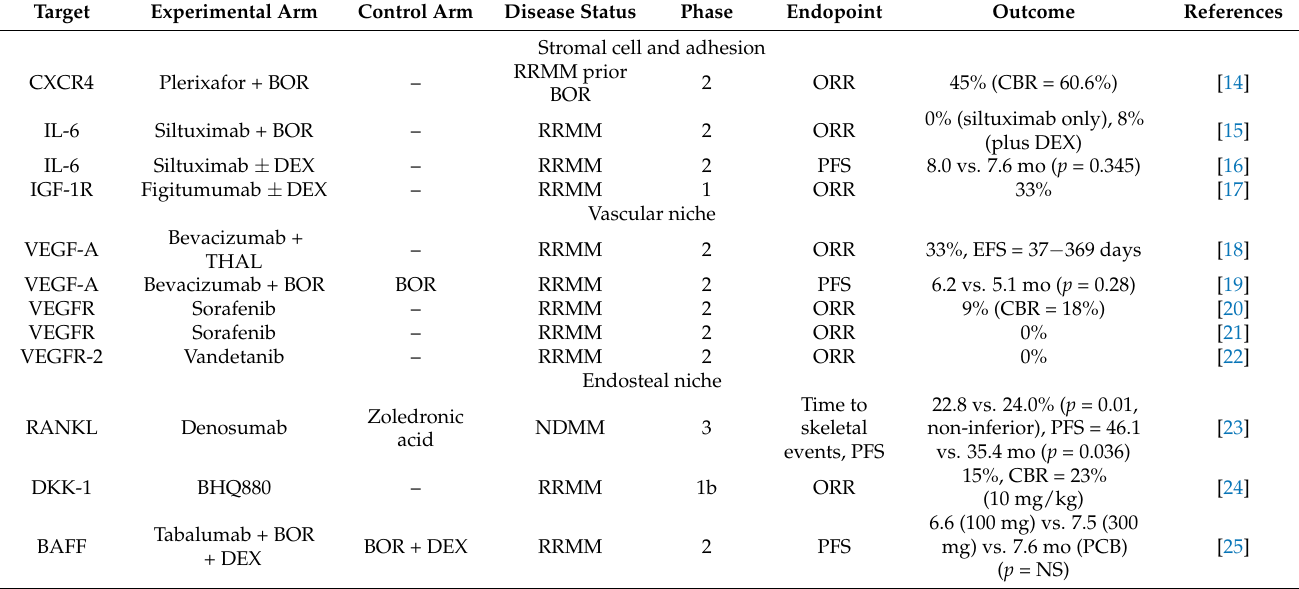
Table 1. Clinical trials of new agents for target concerning bone marrow microenvironments in multiple myeloma (MM). BOR, bortezomib; THAL, thalidomide; DEX, dexamethasone; PCB, placebo; CXCR4, C-X-C chemokine receptor type 4; IL-6, interleukin-6; IGF-1R, insulin-like growth factor-1 receptor; VEGF, vascular endothelial growth factor; VEGFR, vascular endothelial growth factor receptor; RANKL, receptor activator of nuclear factor kappa-B ligand; DKK-1, Dickkopf-1; BAFF, B cell activating factor; NDMM, newly diagnosed multiple myeloma; RRMM, relapsed or refractory multiple myeloma; ORR, overall response rate; CBR, clinical benefit rate; PFS, progression free survival; EFS, event free survival; mo, months, NS = not